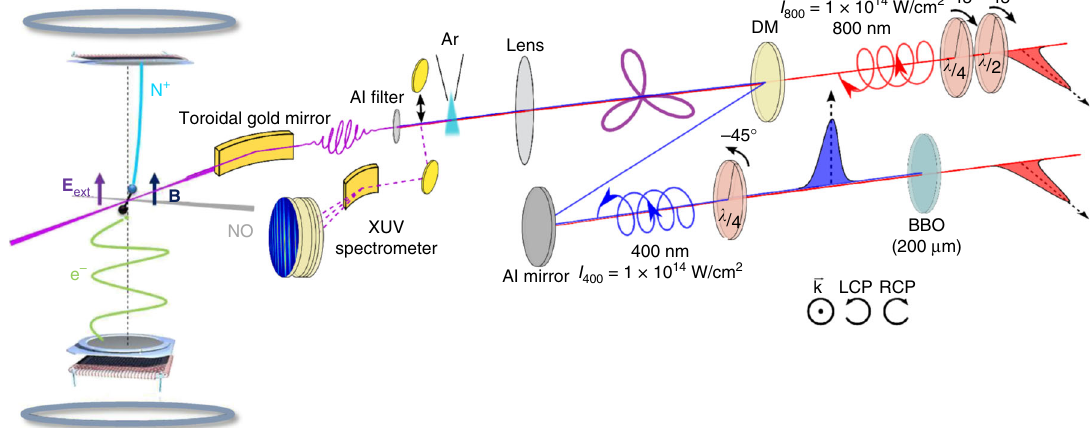
Fig. 4 Experimental setup for the complete characterization of the harmonic polarization state. A 1-kHz 3-mJ 800-nm beam is split into two in a Mach – Zehnder interferometer. In one arm, a BBO crystal generates the 400-nm pulses. A zero-order quarter-wave plate ( λ /4) is placed in each arm to control the ellipticity of the fi elds, and an additional half-wave plate ( λ /2) is placed in the fundamental arm to rotate its polarization along the s axis. After recombination on a dichroic mirror (DM), the two beams are focused into an argon gas jet for HHG. The XUV emission can be sent to a photon spectrometer with a movable mirror, or fi ltered with an aluminum foil and refocused by a toroidal mirror at the center of an electron-ion coincidence 3D momentum spectrometer 42,60 (and references therein) where it intersects the NO supersonic molecular jet. Electron and ion trajectories are controlled by coupled electric and magnetic fi elds set in the spectrometer combined with two delay-line time- and position-sensitive detectors, ensuring a 4 π collection of both particles for the studied DPI reaction (1). For details see the Methods